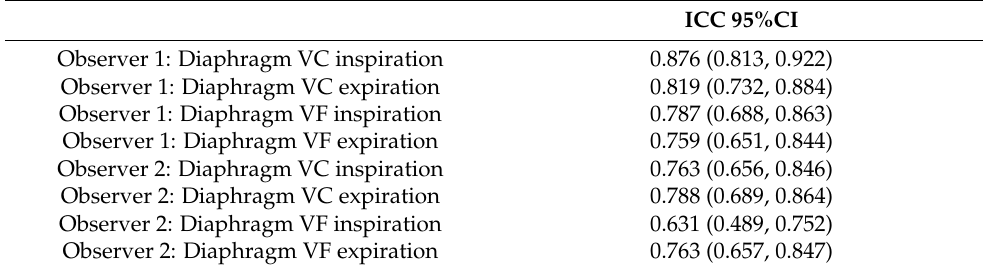
Table 3. ICC results for intraobserver